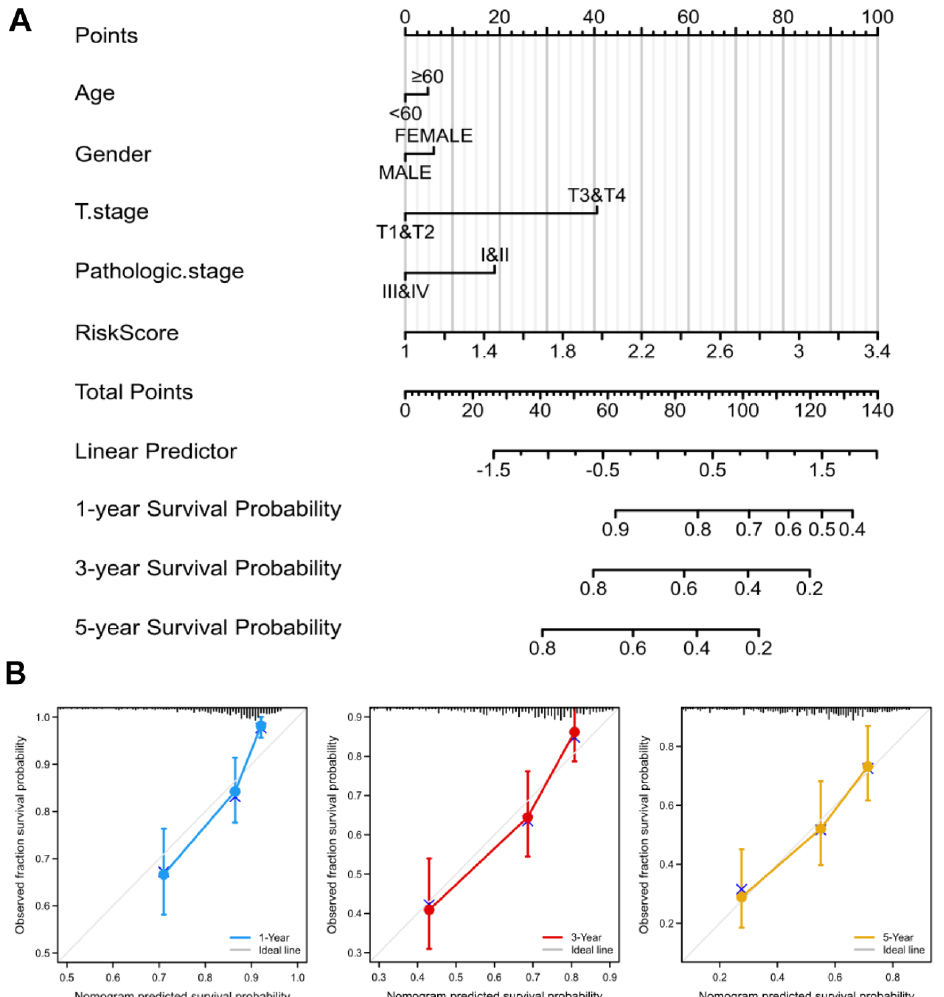
Figure 5. Nomogram to predict survival probability of HCC patients. ( A ) The predictive probability of the risk score with pathologic features in the nomogram. ( B ) Calibration plots for predicting 1-, 3-, and 5-year OS of HCC patients.